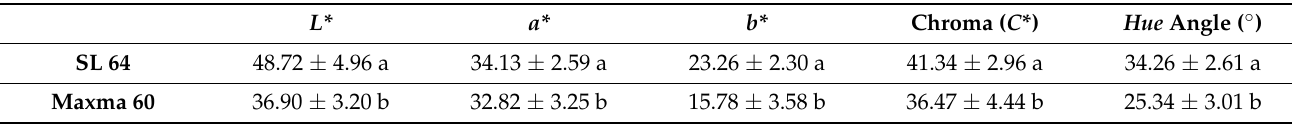
Table 1. Chromatic parameters of sweet cherry cv. Early Bigi grafted on SL 64 and Maxma 60 rootstocks. Different letters indicate statistically significant differences ( p < 0.05) according to Duncan’s